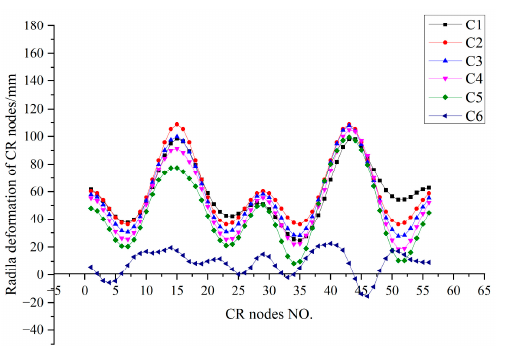
process. When the tension of the tie-downs is completed, the CR basically reaches the de- sign configuration.